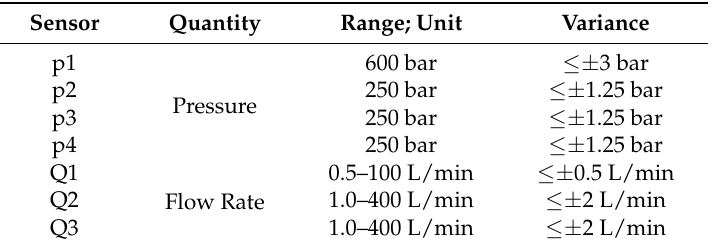
Table 3. Properties of sensors used for the T/A-LV Test Rig (Figure